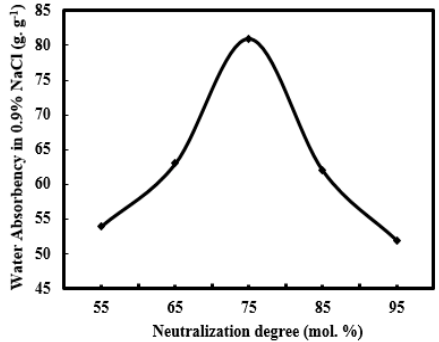
Figure 3. Effect of neutralization degree on water absorbency of PAA-AM/FA in 0.9% NaCl aqueous solution (polymerization temperature, 70 °C; mass ratio of AA/AM, 1.5; crosslinker concentration, 0.7%; FA concentration, 50%).